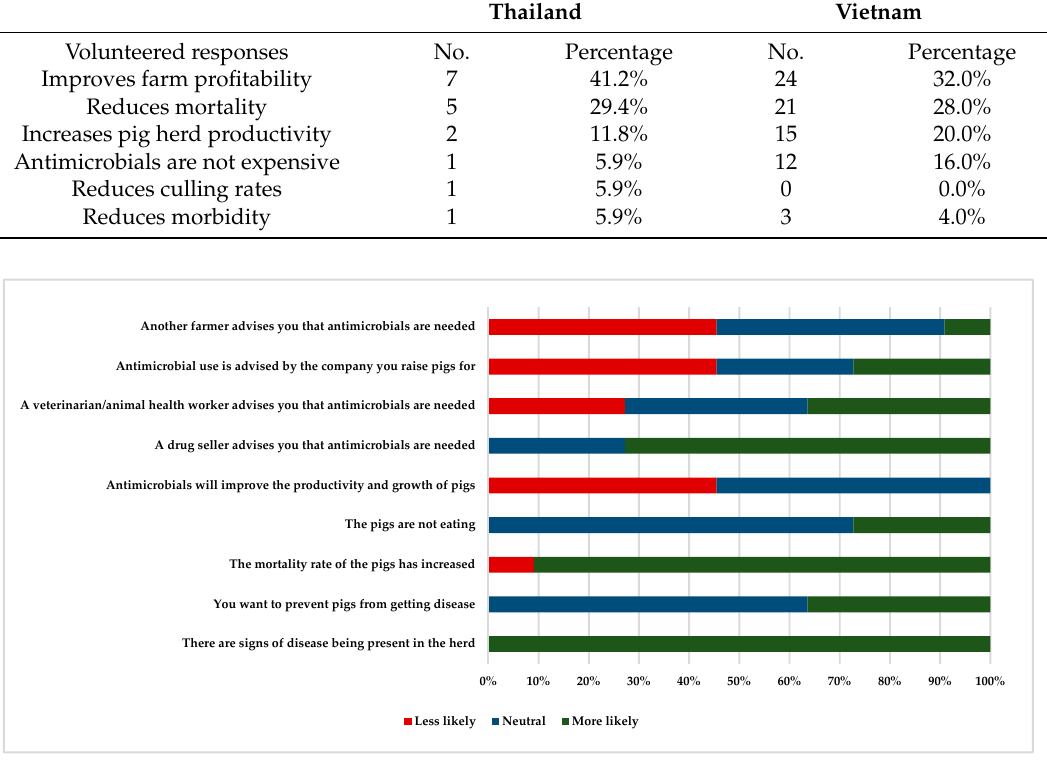
Figure 2. The behavioural influences behind antimicrobial use in a case study on antimicrobial use on pig farms in Thailand (n = 11).